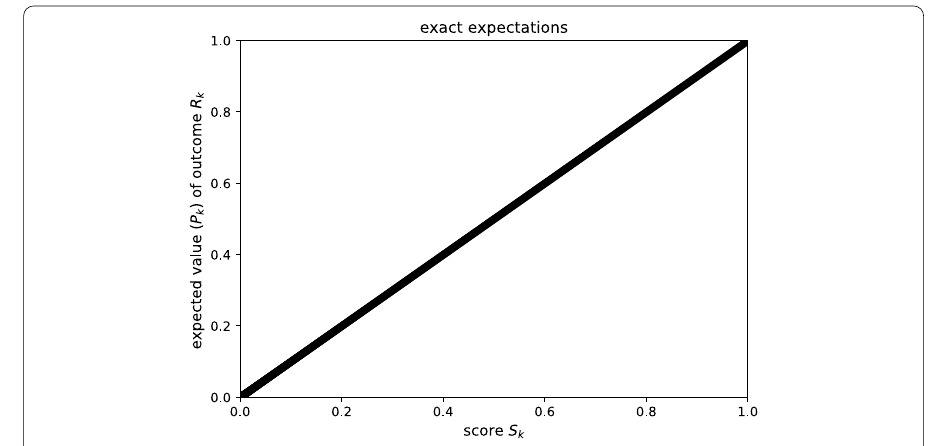
Fig. 49 Ground-truth reliability diagram for Fig. 48